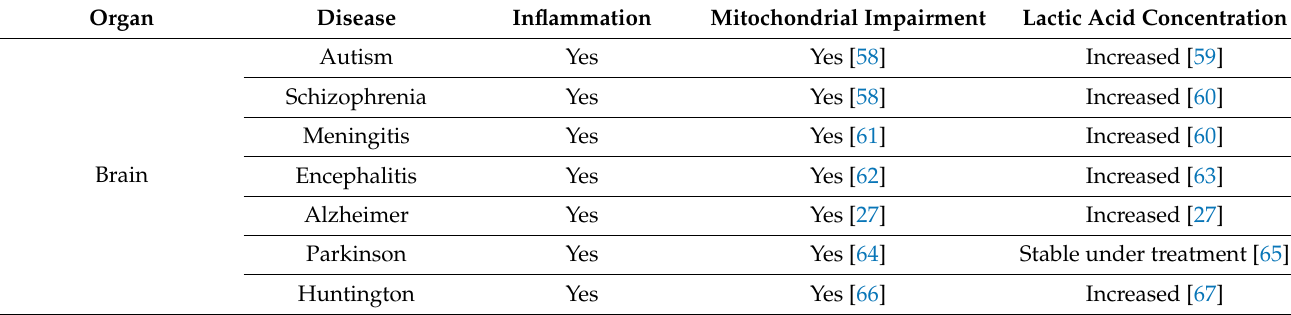
Table 1. Every disease has an inflammatory component associated with malfunctioning mitochondria and increased secretion of lactic acid resulting from metabolic rewiring.